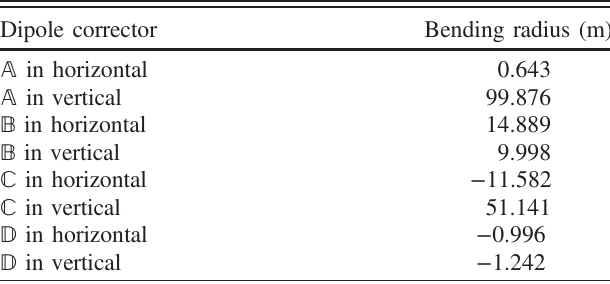
TABLE IV. Bending radii for the correctors shown in Fig. 1, chosen to minimize the final beam emittance without space charge for a beam emitted 2 mm off-axis.